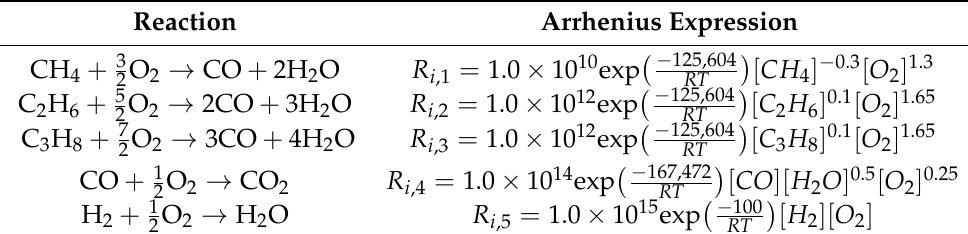
Table 4. Five-step combustion mechanism